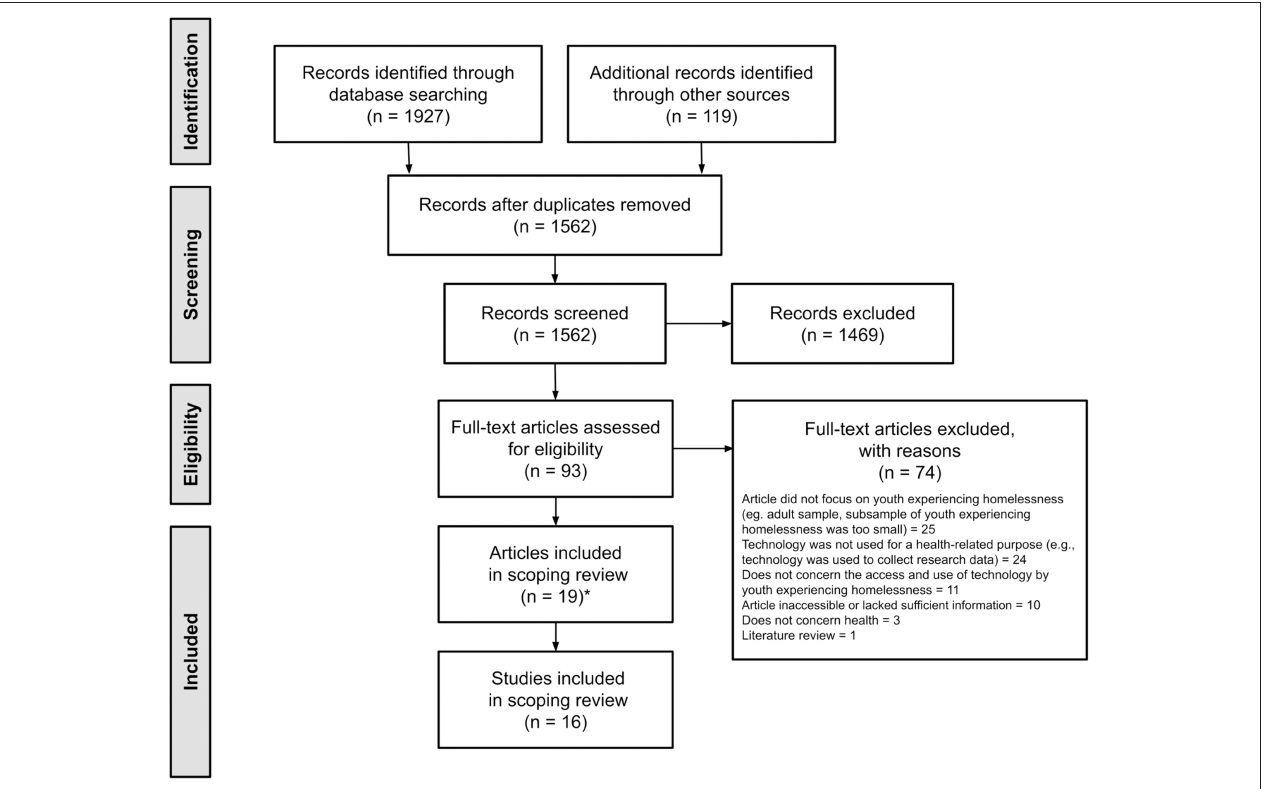
FIGURE 2 | Preferred Reporting Items for Systematic reviews and Meta-Analyses (PRISMA) diagram. *Six of the articles were grouped together into three pairs, as each set reported on data collected from the same